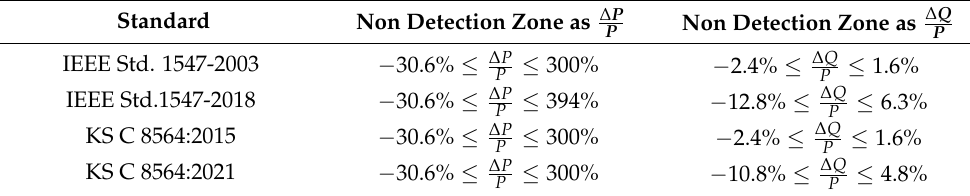
Table 3. Non-detection zone analysis by